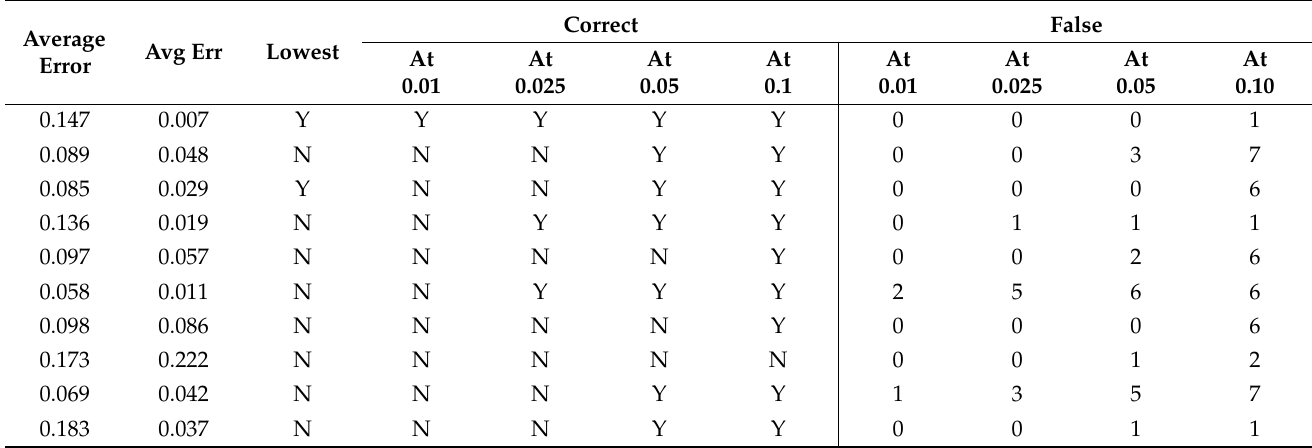
Table A214. Set 3, trials 31–40 summary data (actual PR value).